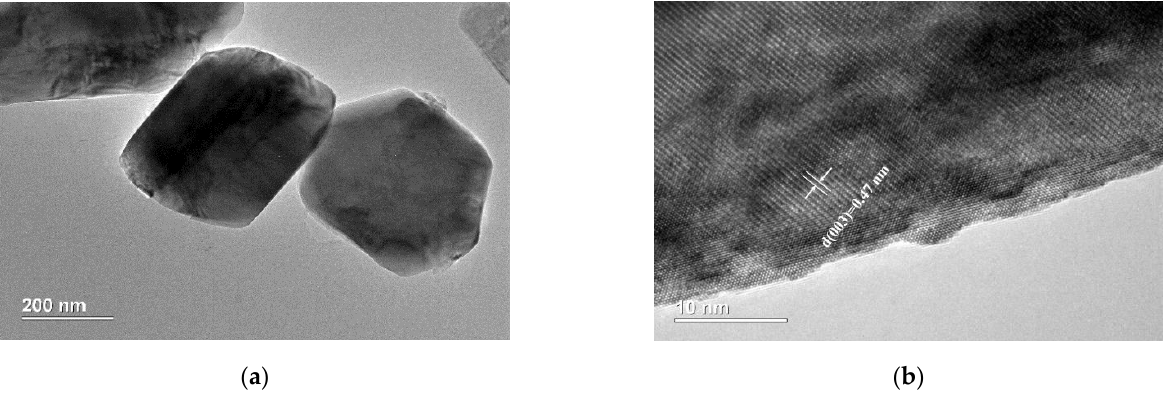
Figure 4. Transmission electron microscope (TEM) image ( a ) and high-resolution TEM (HRTEM) image ( b ) of LiNi 2/3 Co 1/6 Mn 1/6 O 2 calcinated at 800 °C.